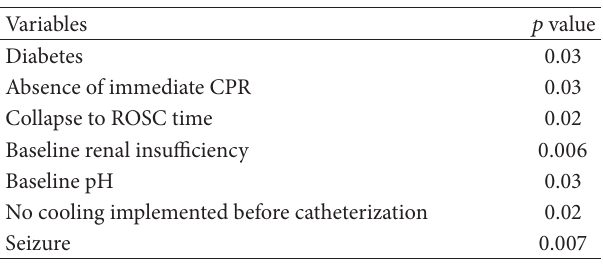
Table 5: Univariate negative predictors of good neurologic outcome in study population who underwent MTH + C ( 𝑛 = 66